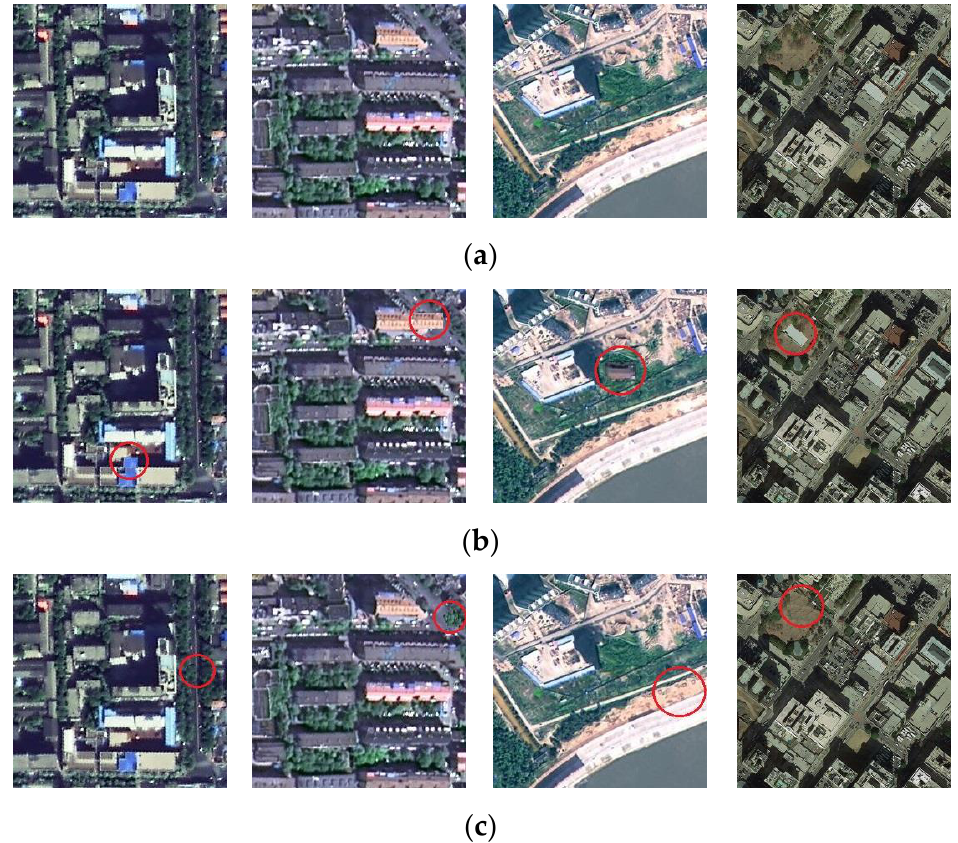
Figure 2. Example of subject related tampering and subject unrelated tampering: ( a ) Original HRRS images, ( b ) subject-related tampering, ( c ) subject unrelated tampering.